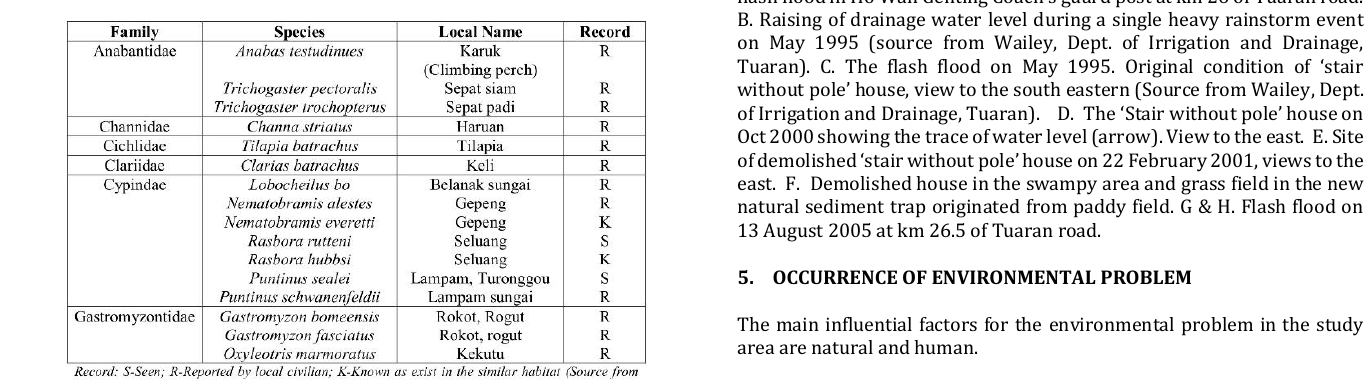
Table 5 : Recoded and observed biological fresh water community